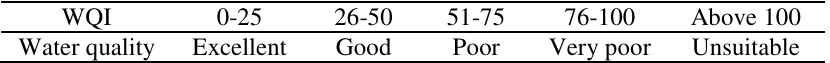
Table 1. Water quality index